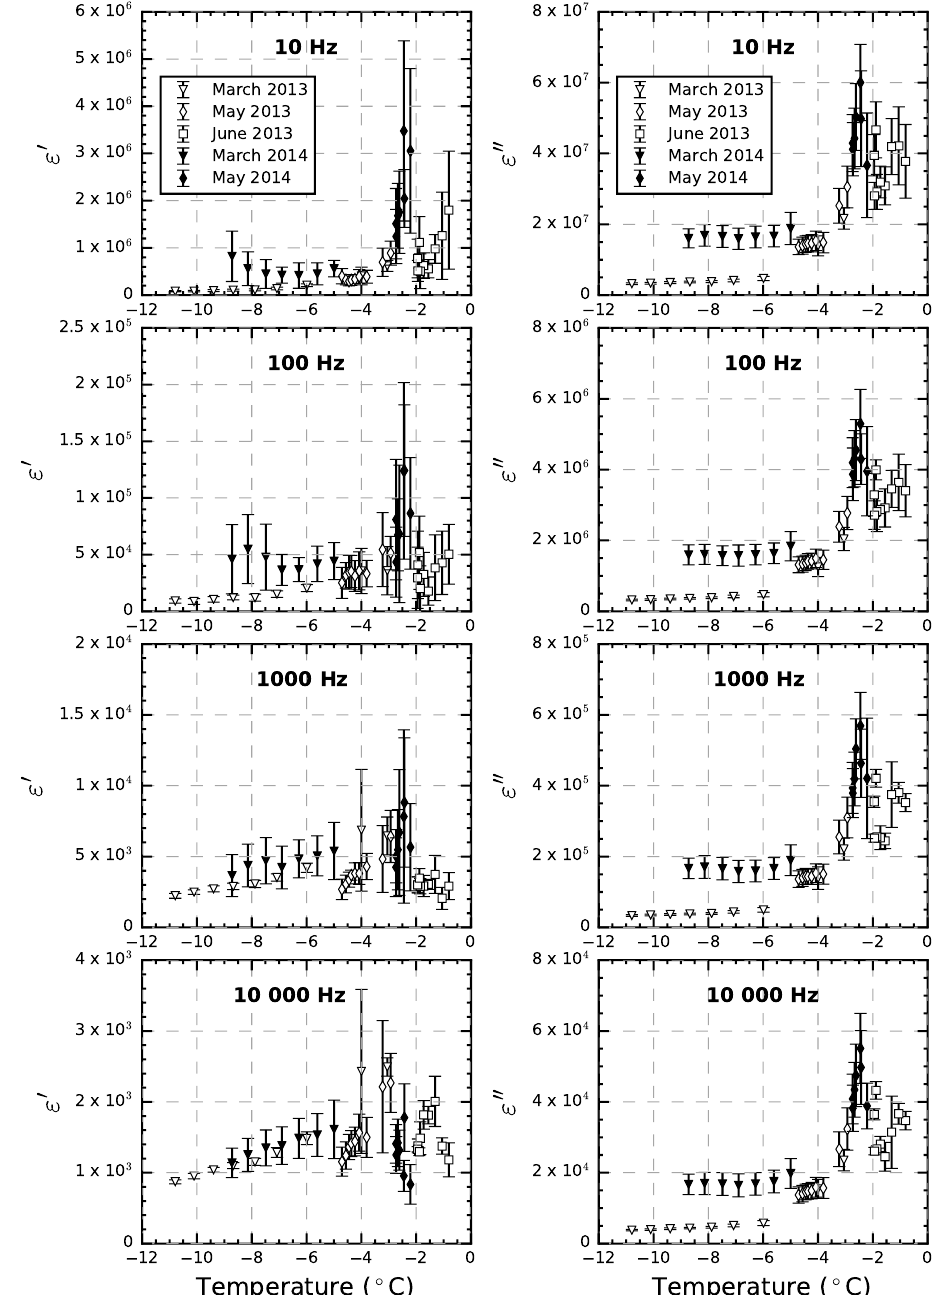
Figure 6. Variation of the real ( ε (cid:48) ) and imaginary ( ε (cid:48)(cid:48) ) parts of the measured permittivity as a function of temperature. Triangles: late March; diamonds: mid-May; squares: early June; open symbols: 2013; filled symbols: 2014.